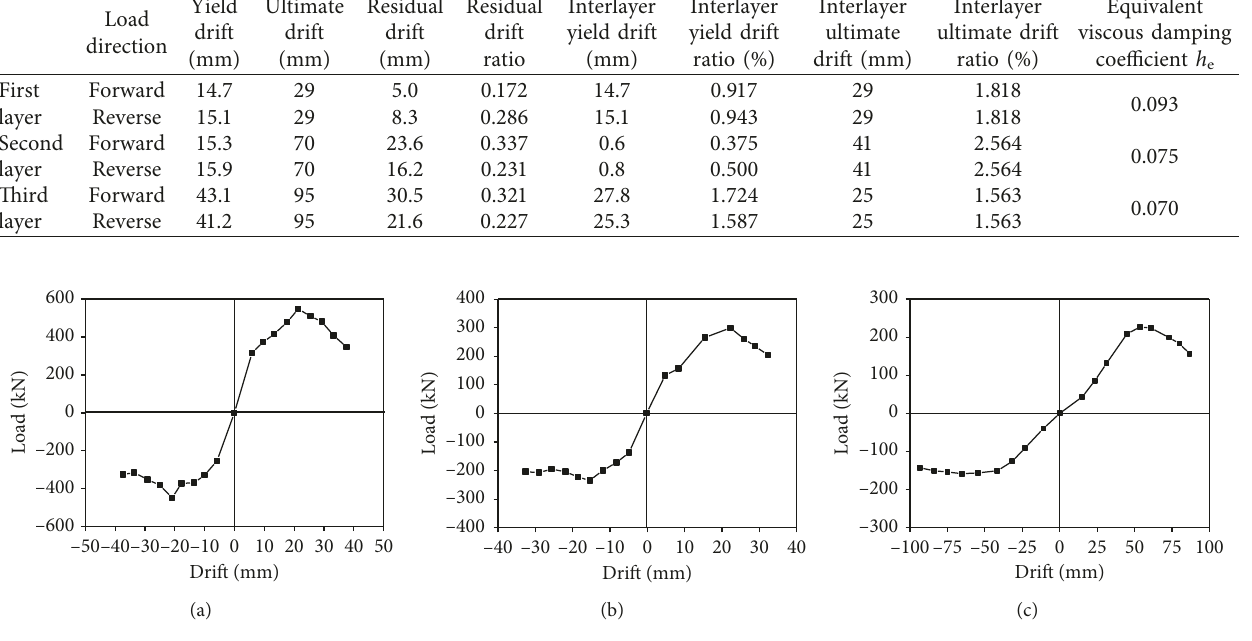
Figure 11: The skeleton curves of each layer. (a) First layer. (b) Second layer. (c) Third